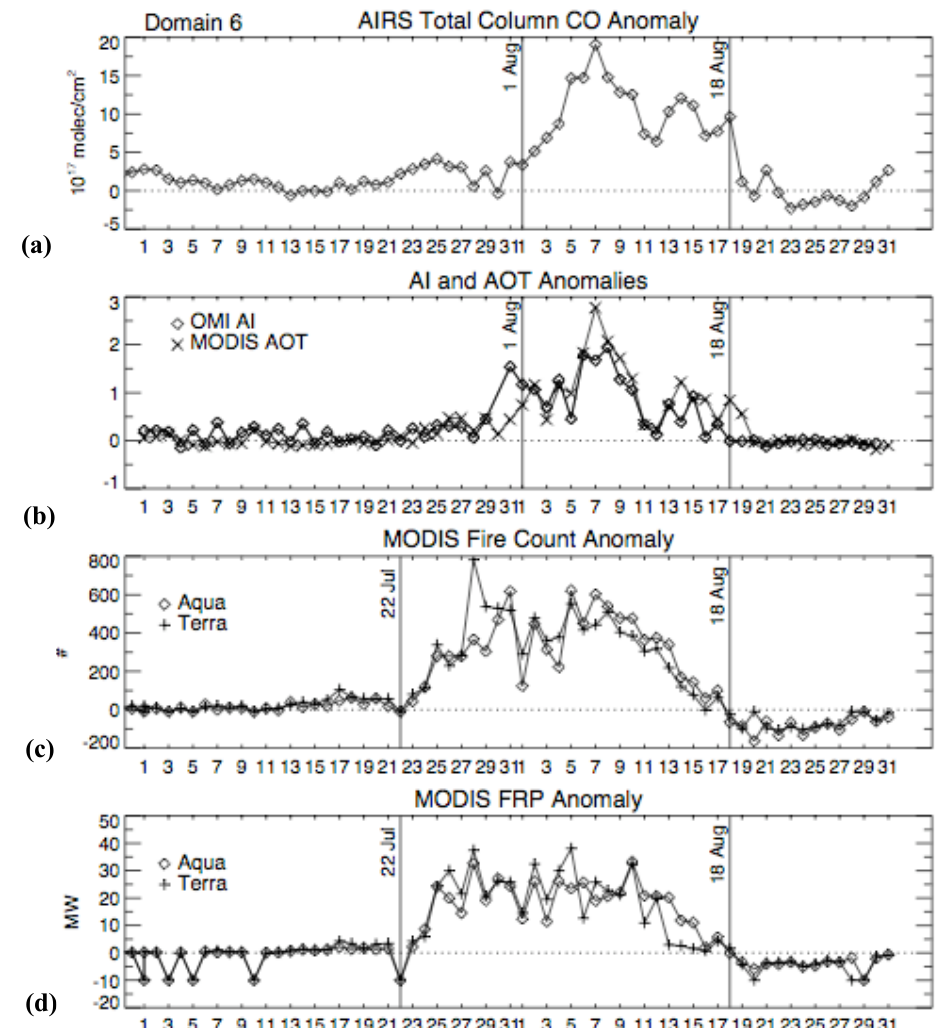
Fig. 5. July and August 2010 anomalies of (a) AIRS CO TC , (b) OMI AI and MODIS AOT . 55 , (c) MODIS fire counts, and (d) MODIS FRP over domain 6 (52–58 ◦ N, 33–43 ◦ E). Anomalies for each constituent were calculated by subtracting the 2010 daily values from the daily mean of all previous years. MODIS AOT . 55 anomalies in (b) are calculated using the mean of Aqua and Terra.